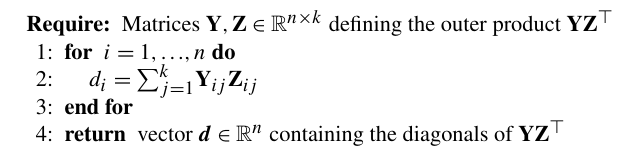
Algorithm 2 Compute the diagonals of the low-rank